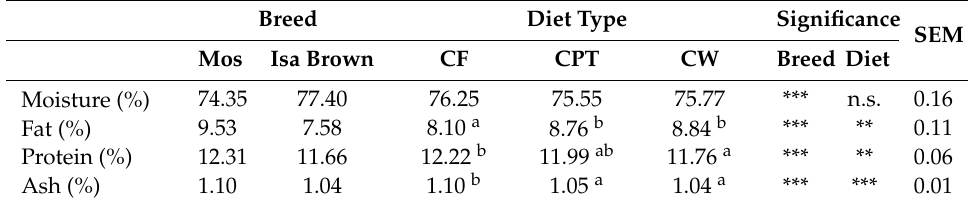
Table 5. E ff ect of breed (Mos vs. Isa Brown) and diet type (CF, CPT and CW) on